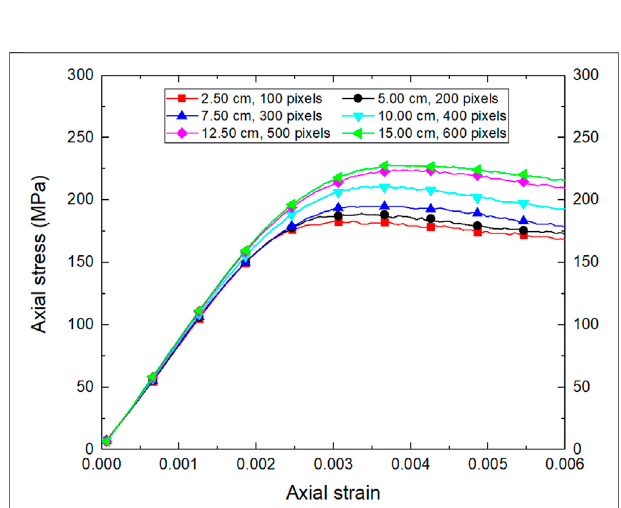
FIGURE 12 | The stress-strain law of digital granite with different